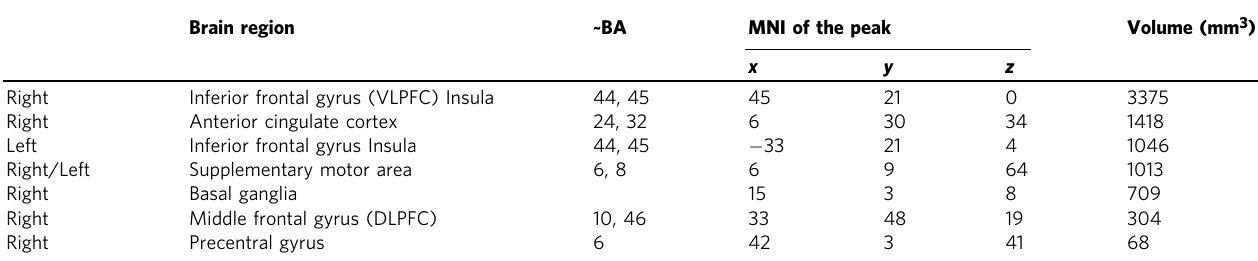
Table 2 Control network regions showing a signi fi cant pattern of brain/behaviour correlations as revealed by the fi rst latent variable of the PLS